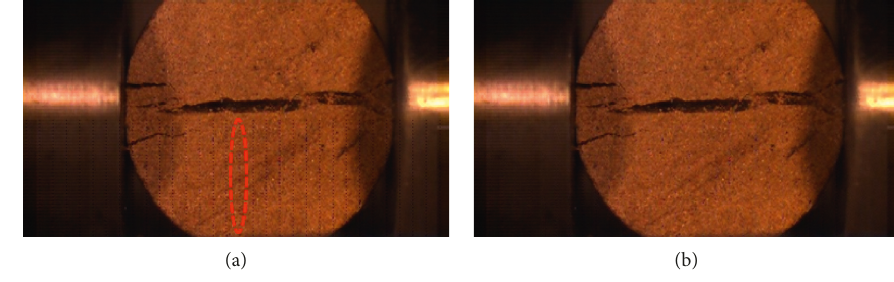
Figure 8: Image result after nonlocal mean filtering.